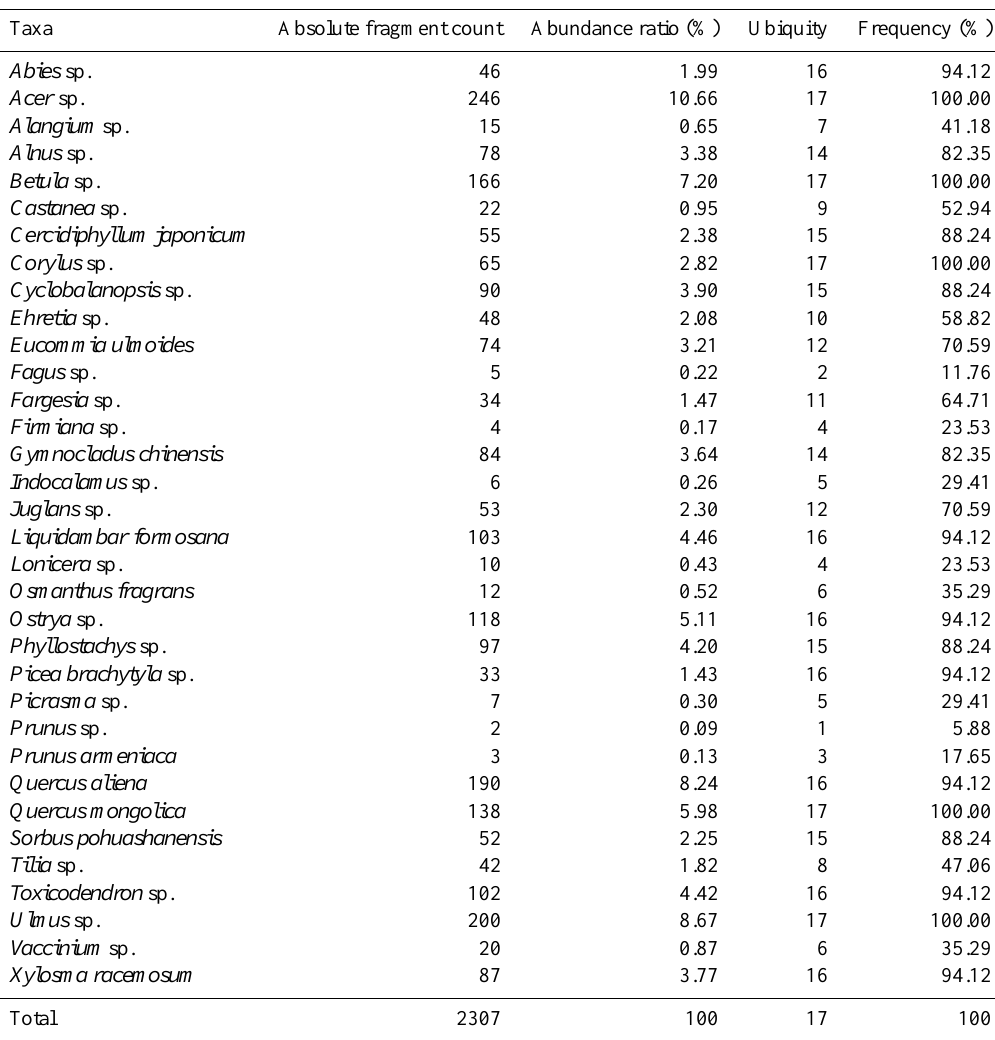
Table 2. The taxa of fossil charcoal and their relative frequencies and abundance ratio from the Dadiwan site. Taxa Absolute fragment count Abundance ratio (%) Ubiquity Frequency (%) Abies sp. Acer sp. 246 100.00 Alangium sp. Alnus sp. Betula sp. Castanea sp. Corylus sp. Cyclobalanopsis sp. Ehretia sp.